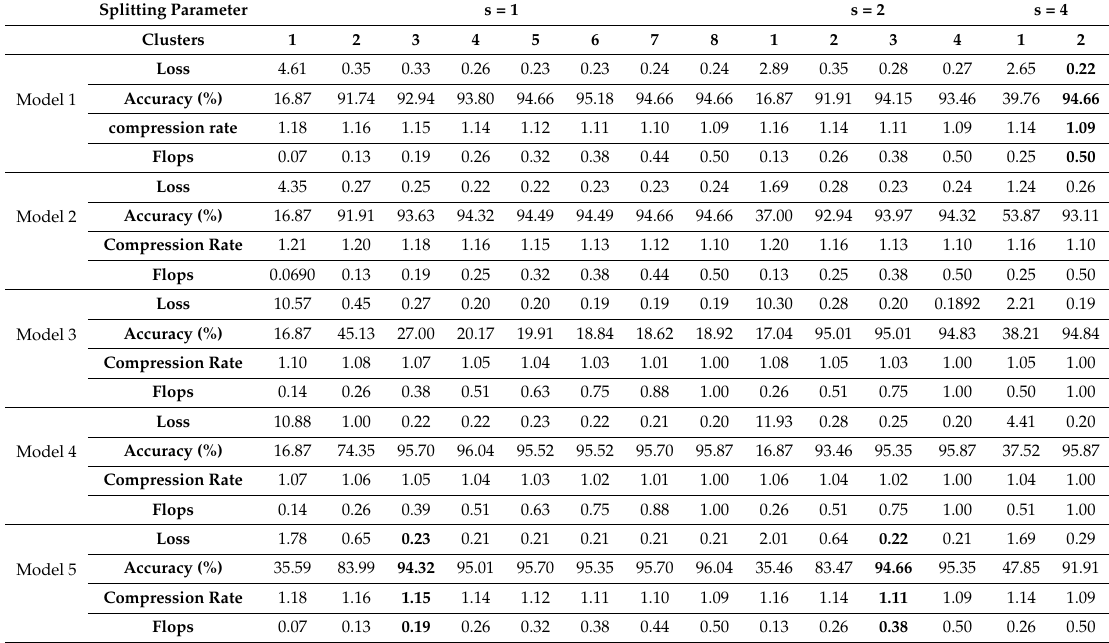
Table 9. Product quantization for all combinations of s and clusters on convolutional layers